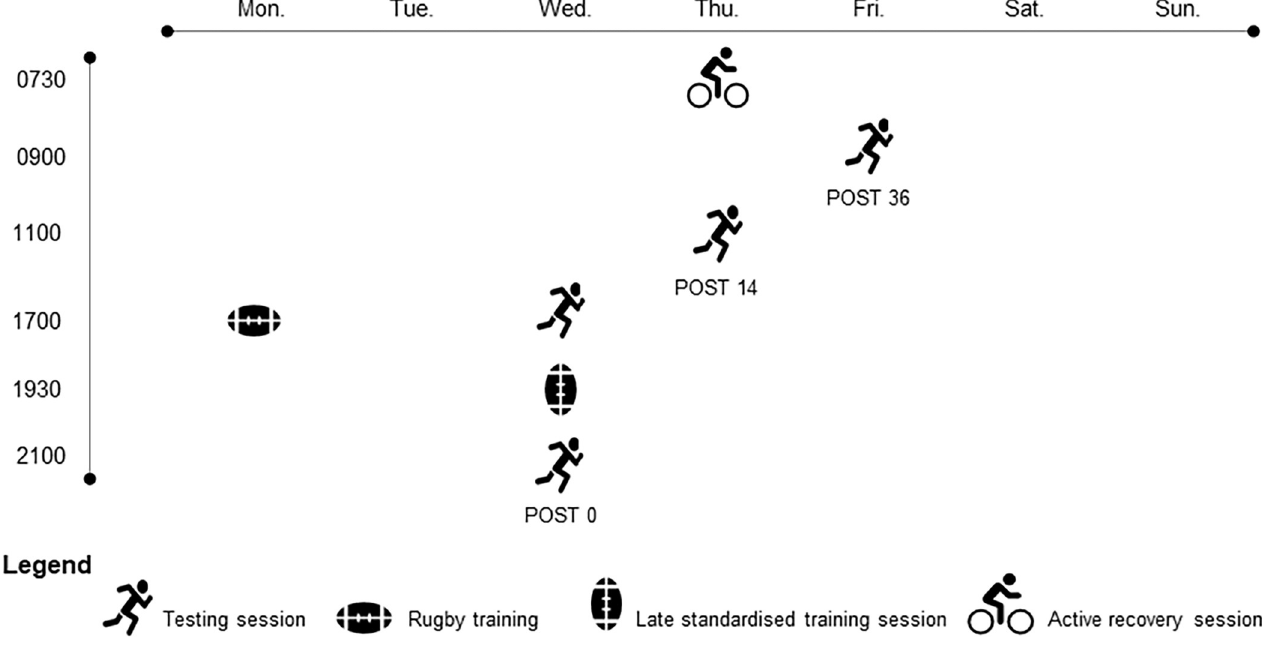
Fig 2. Weekly organisation of the